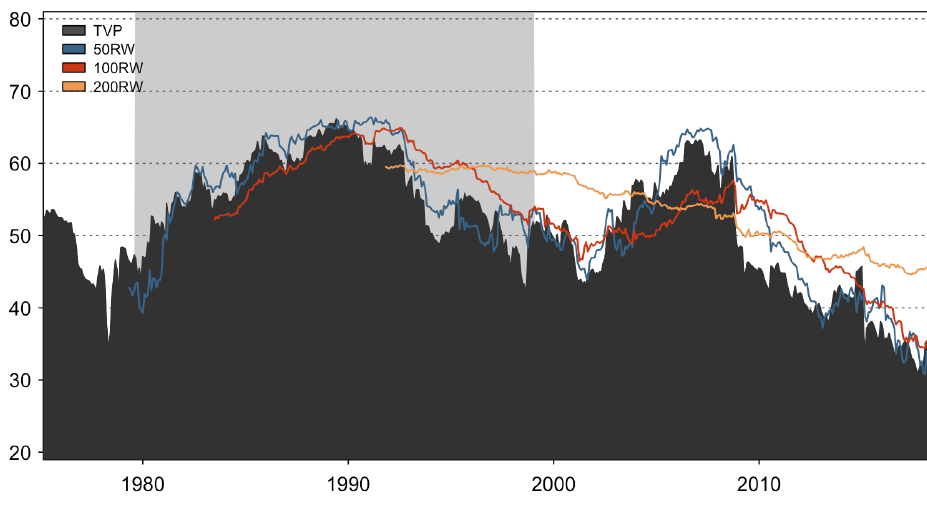
Figure 7. Dynamic total